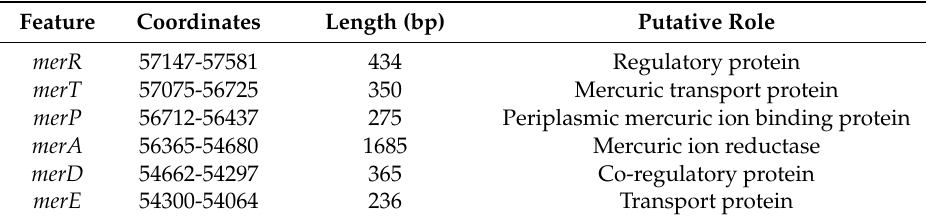
Table 1. Genes identified for mercury resistance in Stenotrophomonas sp. strain